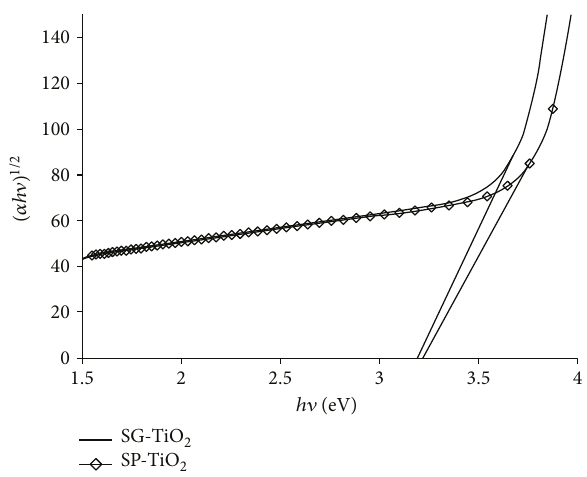
Figure 5: The energy bandgaps of the SG-TiO thin fi lms.